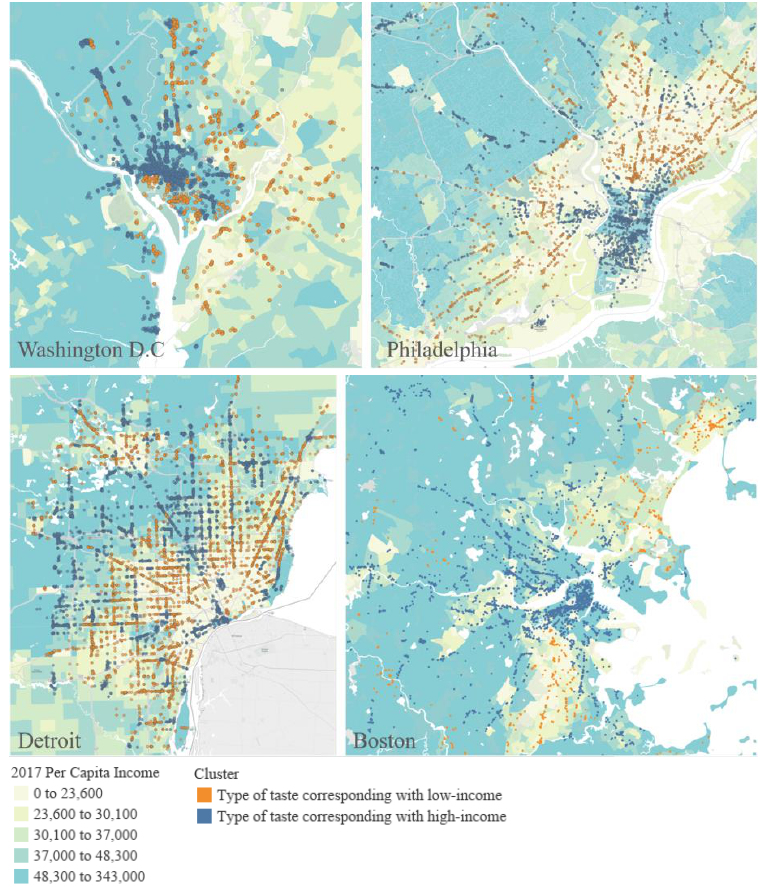
Figure 8. Clustering results overlaid on per capita income map for four cities. As we can see the two clusters clearly correspond with block-group level income per capita map from Census. Table 5. Number of restaurants in the two clusters for different